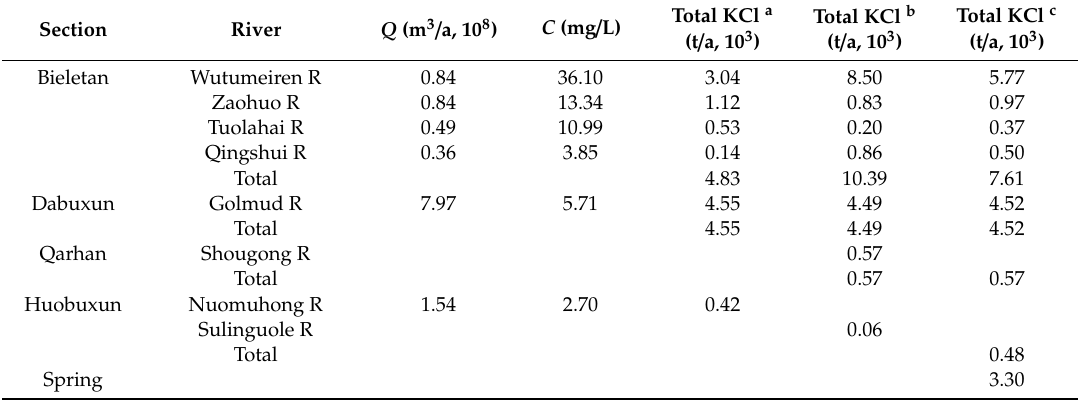
Table 2. The total amount of KCl brought by rivers in the eastern Kunlun